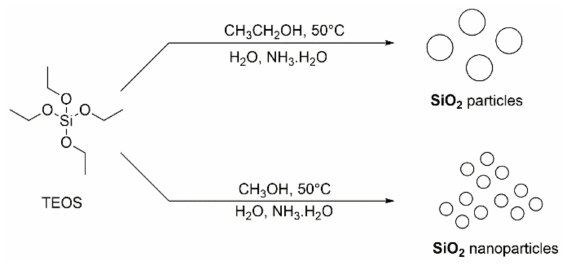
Figure 3. Synthesis of SiO 2 particles.